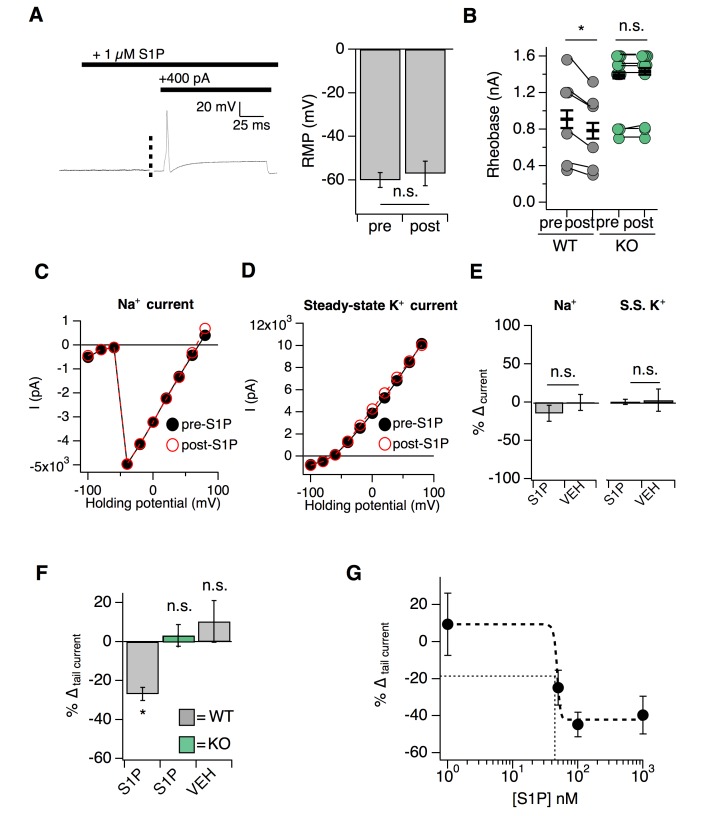
S1P selectively modulates potassium tail currents to increase DRG neuron excitability.Related to Figure 5. (A) (Left) Example trace of a single mCherry+ neuron in S1P before and after current injection. (Right) Resting membrane potential (RMP) in millivolts before and after addition of S1P (p=0.23; two-tailed paired t-test; n = 6 cells). (B) Rheobase pre- and post-S1P application in DRG neurons; pWT = 0.011; pKO = 0.28 (two-tailed paired t-test). Same data are represented in Figure 5A. (C) Sodium I-V relationship for a representative S1pr3mCherry/+ medium-diameter neuron pre- and 5 min post- 1 µM S1P using voltage step from −100 to +80 mV (150 ms steps, −80 mV holding). (D) Steady-state I-V relationship for same neuron. (E) (Left) % ∆ in peak sodium current (Na+) after S1P or 1% DMSO vehicle application for medium-diameter mCherry+ neurons; p=0.39 (two-tailed paired t-test; n = 7 cells per group). (Right) % ∆ in peak steady-state current (S.S. K+) after S1P or 1% DMSO vehicle application for medium-diameter mCherry+ neurons; p=0.948 (two-tailed paired t-test; n = 7 cells per group). (F) % ∆ in inward tail current (∆I tail) after S1P or 1% DMSO vehicle application for S1pr3mCherry/+ and KO medium-diameter neurons using a pre-pulse stimulation of +80 mV followed by a step to −80 mV, where (∆I tail) was calculated by subtracting the steady-state current from the absolute peak of the slowly-deactivating current at −80 mV (p=0.014; one-way ANOVA; n = 10, 13, 10 cells). Tukey Kramer post hoc p-values indicated on graph. (G) Dose-response relationship between % ∆ in tail current and S1P concentration for 1 nM, 50 nM, 100 nM, and 1 µM S1P (n = 7 cells). EC50 (48.8 nM), marked by thin dotted lines, was estimated from sigmoidal fit (thick dotted line).